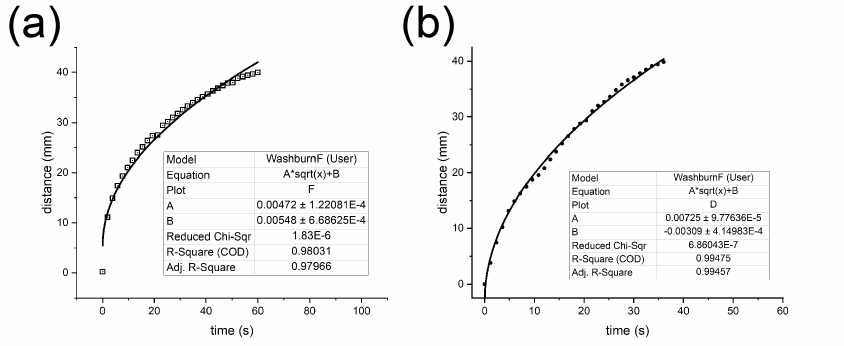
Figure A3. Washburn Equation fitting of flow behavior on nitrocellulose ( a ) and synthetic paper ( b ) test strips.